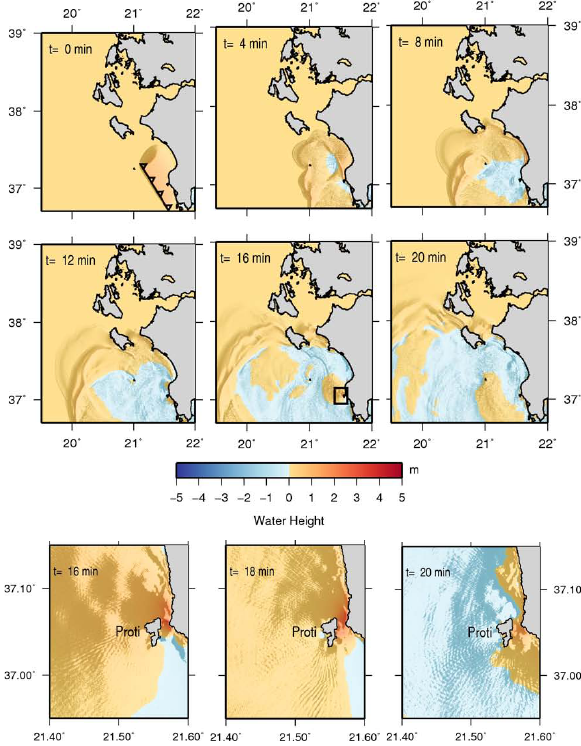
Fig. 3. Snapshots of the tsunami propagation from the source 1 (Filiatra fault) at 4-min intervals. The propagation close to Proti islet is presented in the last row, at a higher magnification.